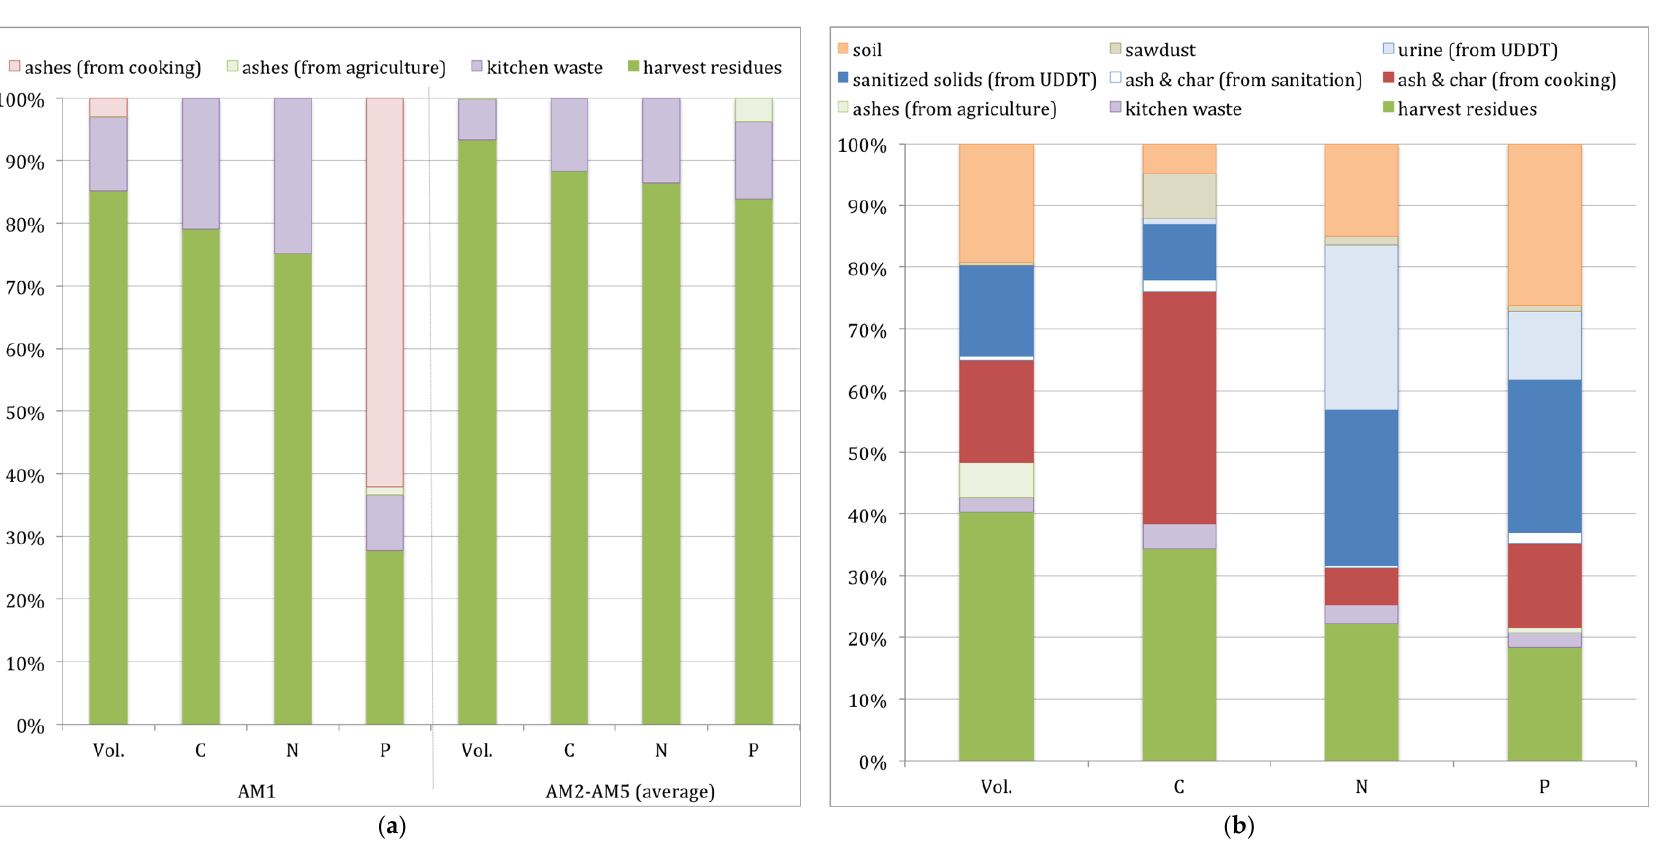
Figure 4. Relative contribution of the different resources used for standard composting (( a ); left) and for CaSa-composting (( b ); right) to the total input flow in terms of volume (Vol.) and content of carbon (C), nitrogen (N), and phosphorus (P) prior to the composting process (values represent the mean percentage calculated for all scenarios). Scenarios are defined in Table 1. Plot data provided in Supplementary Tables S18 (for Figure 4a) and S19 (for Figure 4b).